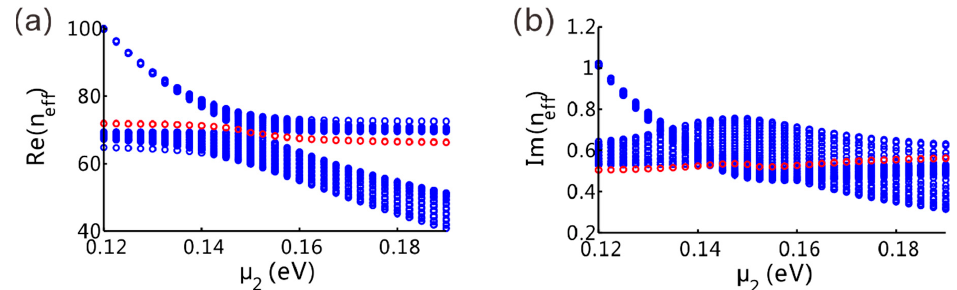
Figure 5. The eigenvalue spectra for di ff erent chemical potentials. ( a ) Real part and ( b ) imaginary part. The red dots represent the topological bound modes.